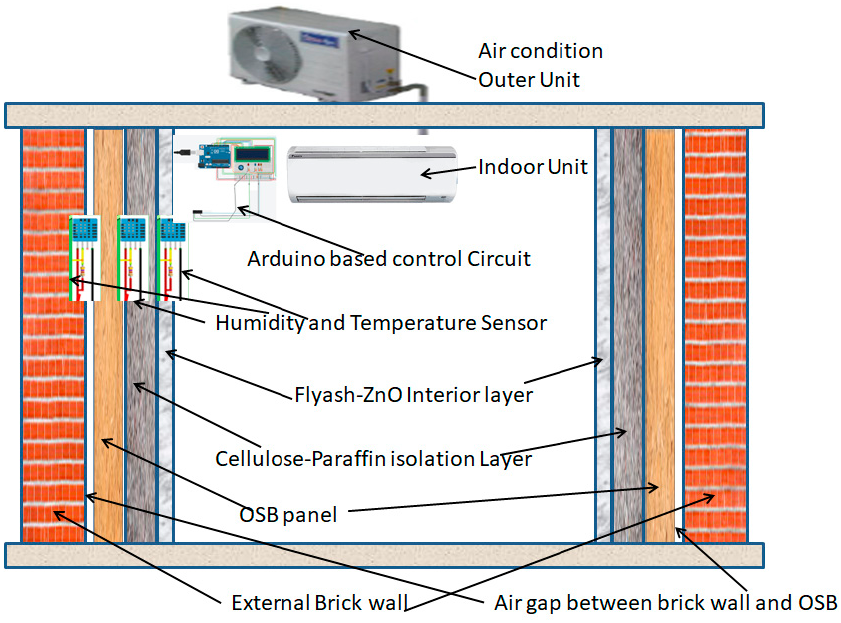
Figure 1. Proposed schematic diagram of the entire research work.